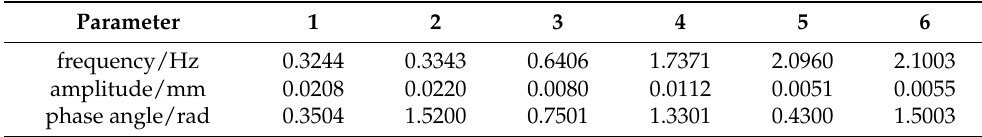
Table 2. The experimental results of eccentricity signal detection.